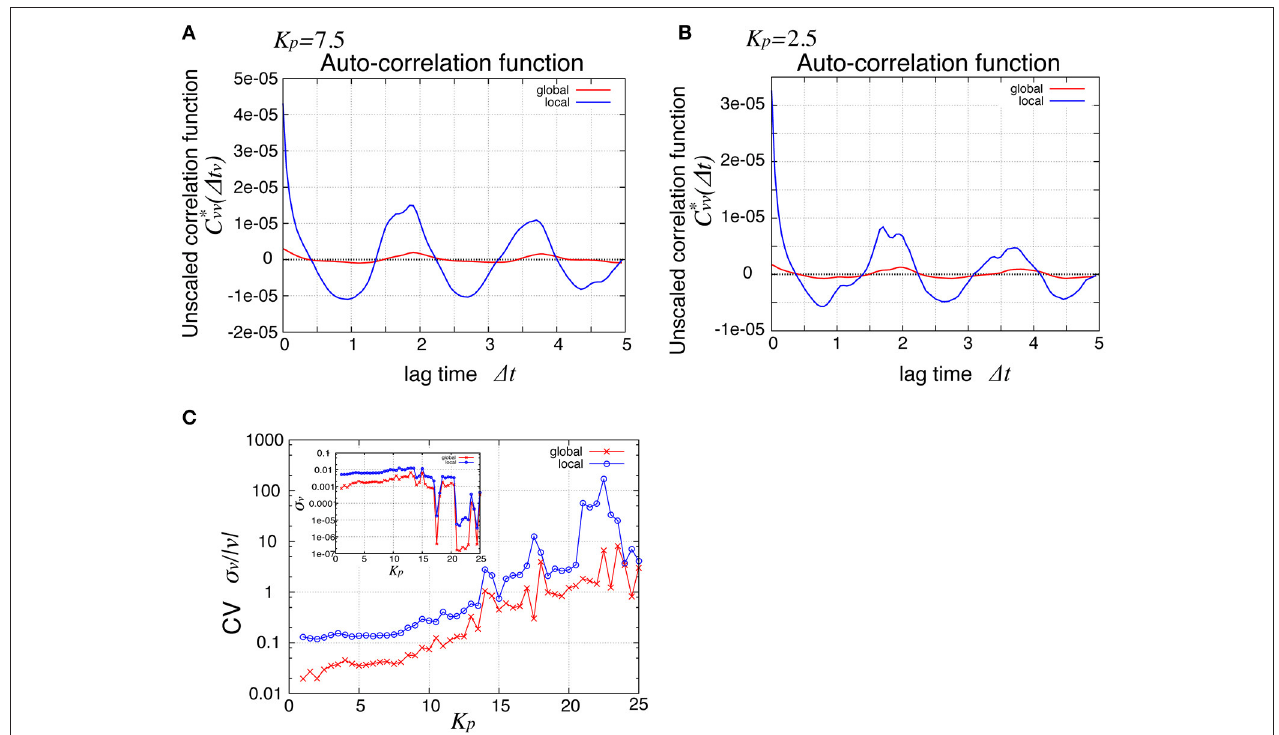
FIGURE 5 | Comparison of global and local behaviors, suggesting the relationship between the spatial propagation and the global oscillation of cell rearrangements. (A,B) Auto-correlation functions C * vv ( ∆ t ) time courses of the angular velocity. Red symbols, for global velocity; blue symbols, local velocity. Inset shows their standard